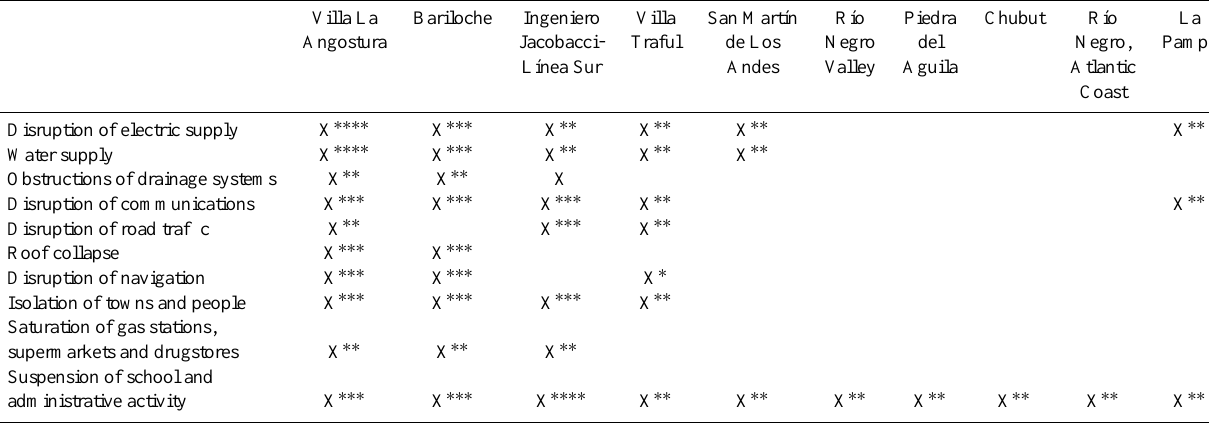
Table 5. Different types of impacts in urban areas and relative duration, as reported in the media (see references in Appendix A). ∗∗∗∗ : first month; ∗∗∗ : first 2 weeks; ∗∗ : first week; ∗ : sporadic.